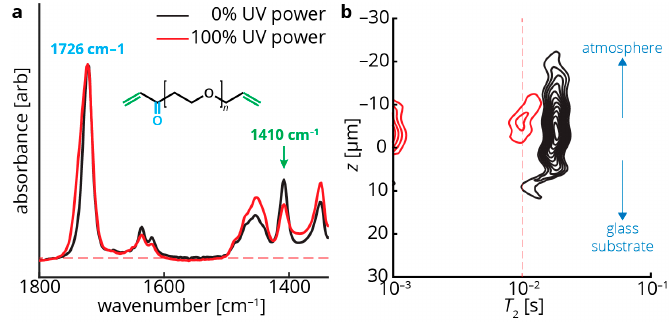
Figure 3. ATR-FTIR (attenuated total reflection–Fourier transform infrared spectroscopy) and single- sided NMR measurements of coating samples both uncured (black) and cured (red). ( a ) ATR-FTIR measurements indicate a peak at 1726 cm − 1 , matching the acrylate carbonyl (cyan in the poly(ethylene glycol) diacrylate (PEDGA) structure) stretch. This peak is expected to remain constant throughout curing as the carbonyl is mostly unaffected by polymerization. The signals are normalized to this peak. In contrast, the peak at 1410 cm − 1 , matching the terminal CH=CH 2 groups (green in the PEGDA structure), diminish with increased crosslinking. ( b ) z – T 2 map showing that increased crosslinking also correlates with a decrease in the measured T 2 values (the peak range shifts to the left). In addition, an additional peak appears in the 100% UV power film (red) at T 2 ~10 − 3 s. This may indicate a second